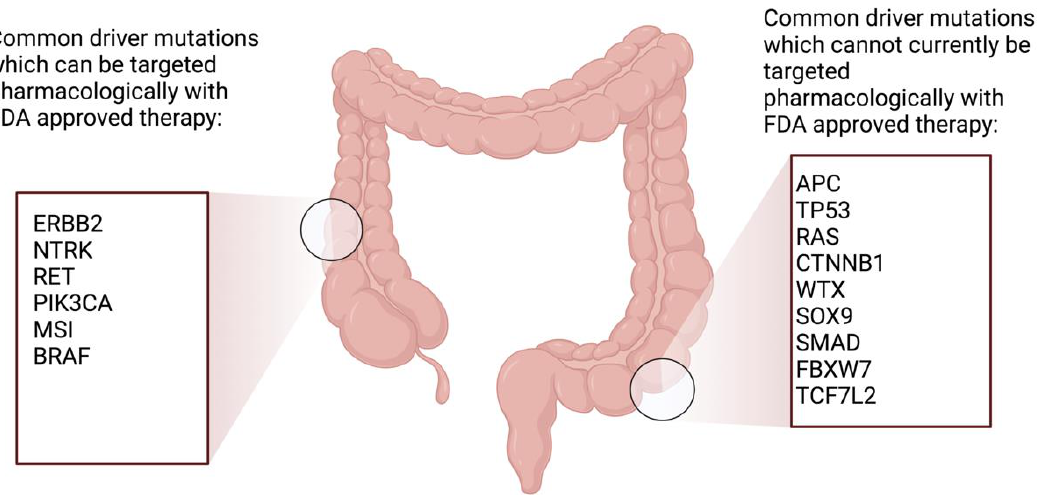
Figure 3. Common genetic mutations seen in EOCRC. Figure developed using